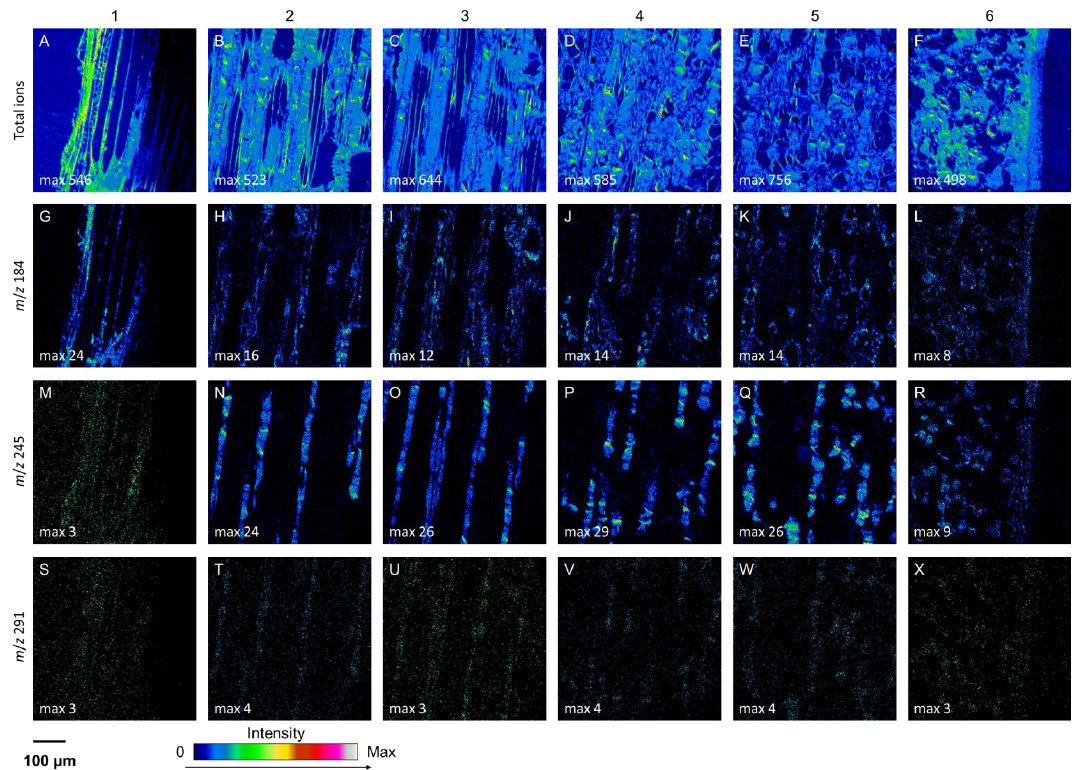
Figure 3. Positive ToF-SIMS images at the radial-longitudinal surface of the phloem in an older, non-treated, healthy Norway spruce tree from the cambium and non-collapsed phloem on the left ( 1 ) to the inner ( 2 ), middle ( 3 – 4 ), and outer ( 5 ) regions of the collapsed phloem, and the outermost collapsed phloem and periderm ( 6 ) on the right. Total secondary ions ( A – F ), m / z at 184 ( G – L ), 245 ( M – R ), and 291 ( S – X ) represent tissue structures, membranes of living cells, trans-astringin, and (+) − catechin, respectively.